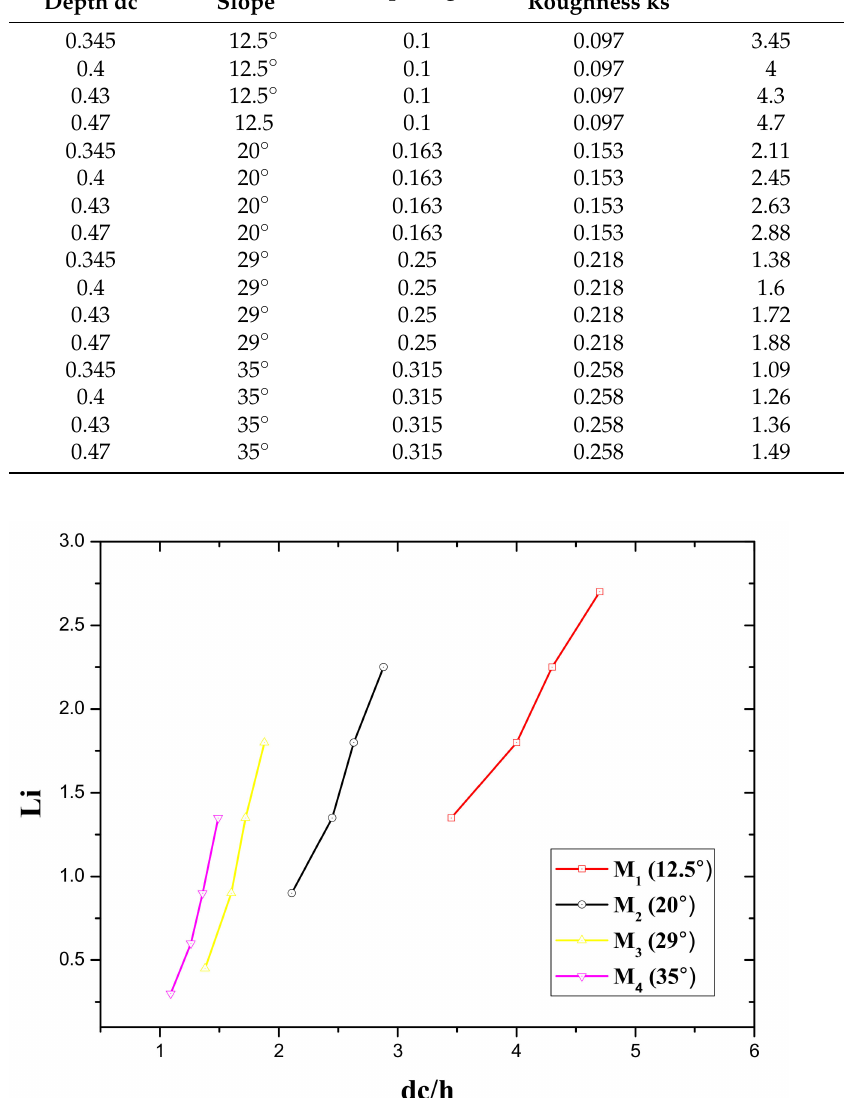
Figure 9. Variation of inception point length with relative critical depth (dc/h) of different sloped stepped